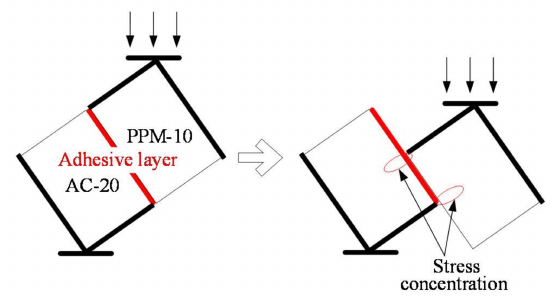
Figure 11. Illustration of stress concentrations during inclined shear test.